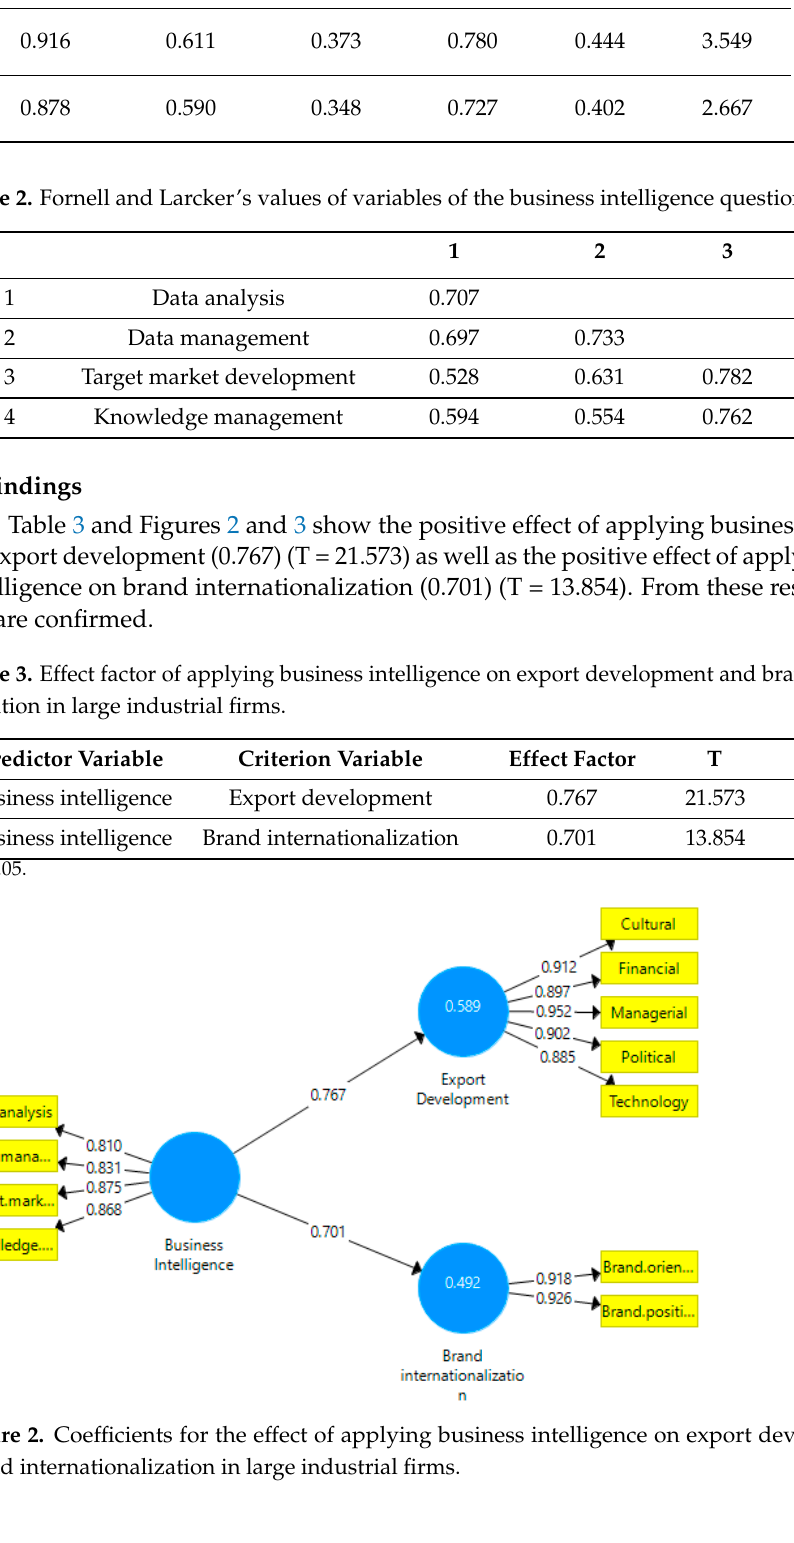
Figure 3. T-values for the effect of applying business intelligence on export development and brand internationalization in large industrial firms. 5. Additional Analyses In this section, we show additional analyses that we conducted to deepen the results of the verified hypotheses. In particular, we investigated (a) the best business intelligence dimensions for the prediction of export development and (b) the best business intelligence dimensions for the prediction of brand internationalization. Regarding point (a), Table 4 shows that the correlation between applying business intelligence and its dimensions (namely knowledge management, data analysis, knowledge management, and target market development) and export development is sig- nificant at p < 0.01. This implies a meaningful relationship between applying business in- telligence and export development (r = 0.775). Regarding the coefficient of determination (r 2 ), 60.1% of the variance of applying business intelligence is shared with export devel- opment.